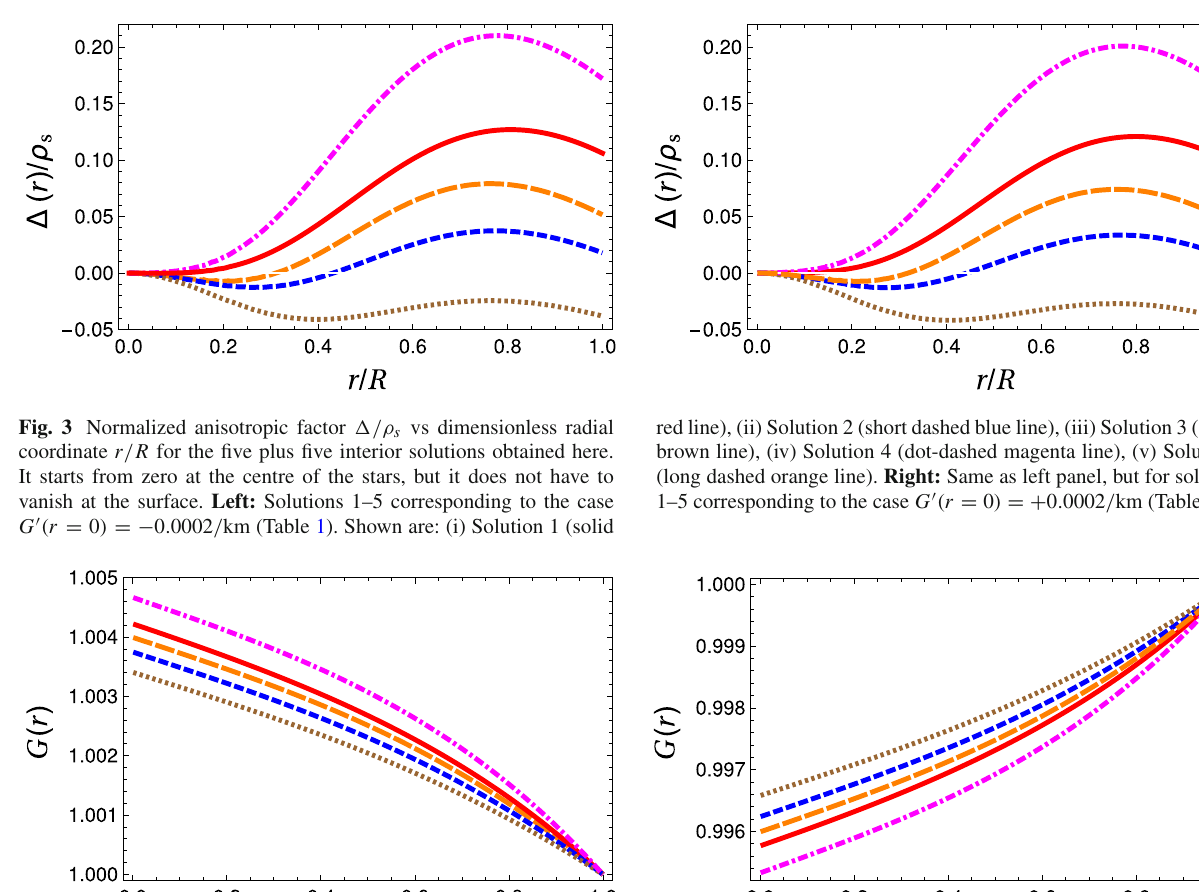
Solution 2 (short dashed blue line), (iii) Solution 3 (dotted brown line), (iv) Solution 4 (dot-dashed magenta line), (v) Solution 5 (long dashed orange line). Right: Same as left panel, but for solutions 1–5 corre- sponding to the case G (cid:5) ( r = 0 ) = + 0 . 0002 / km (Table 2)